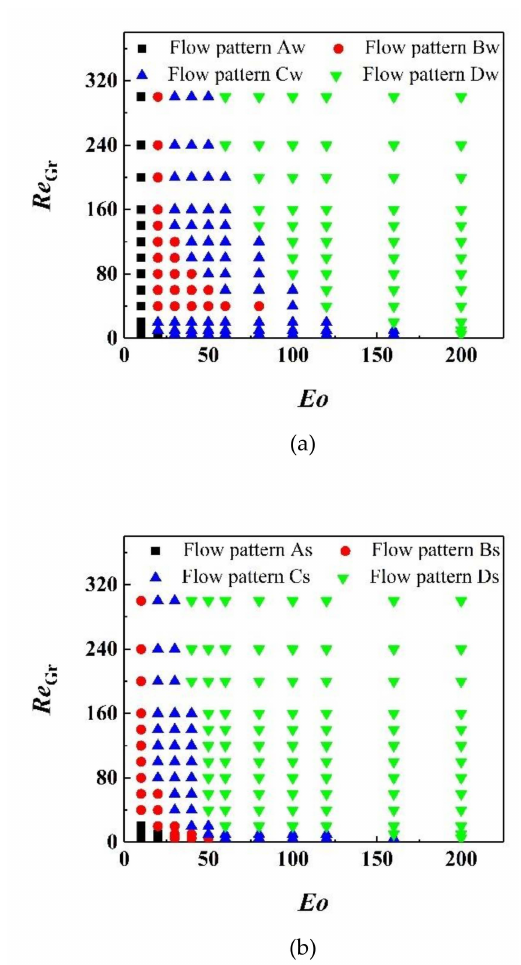
Figure 15. Flow pattern divisions according to Re Gr and Eo in the wavy vertical channel ( a ) and S-shaped curved channel ( b